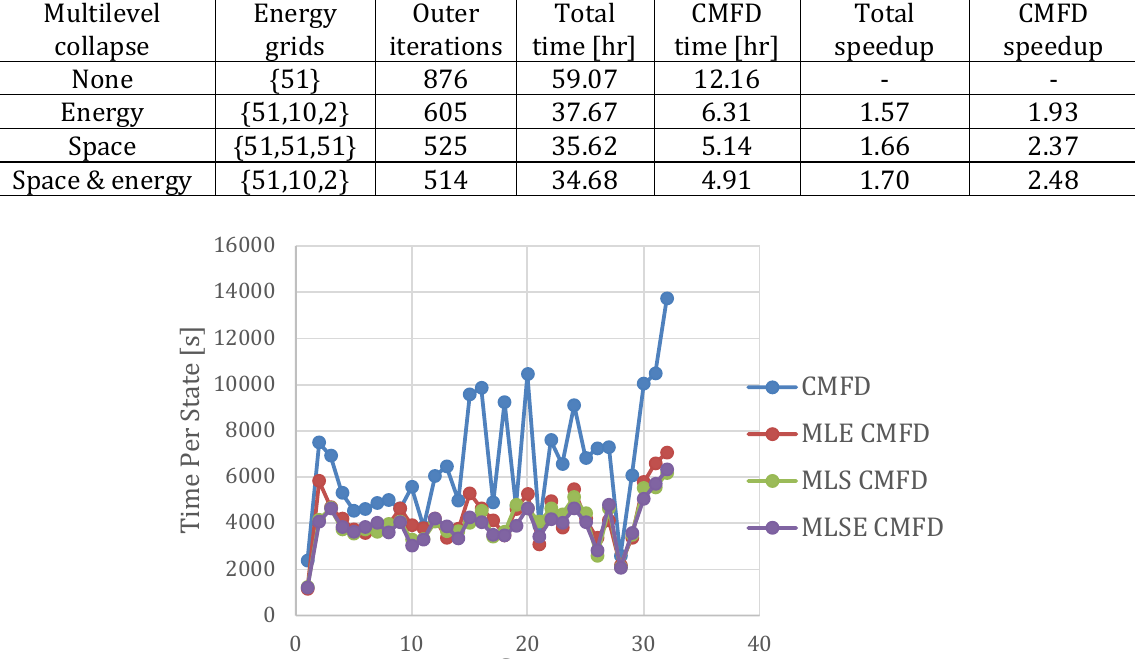
Table II. Problem 9 runtime.